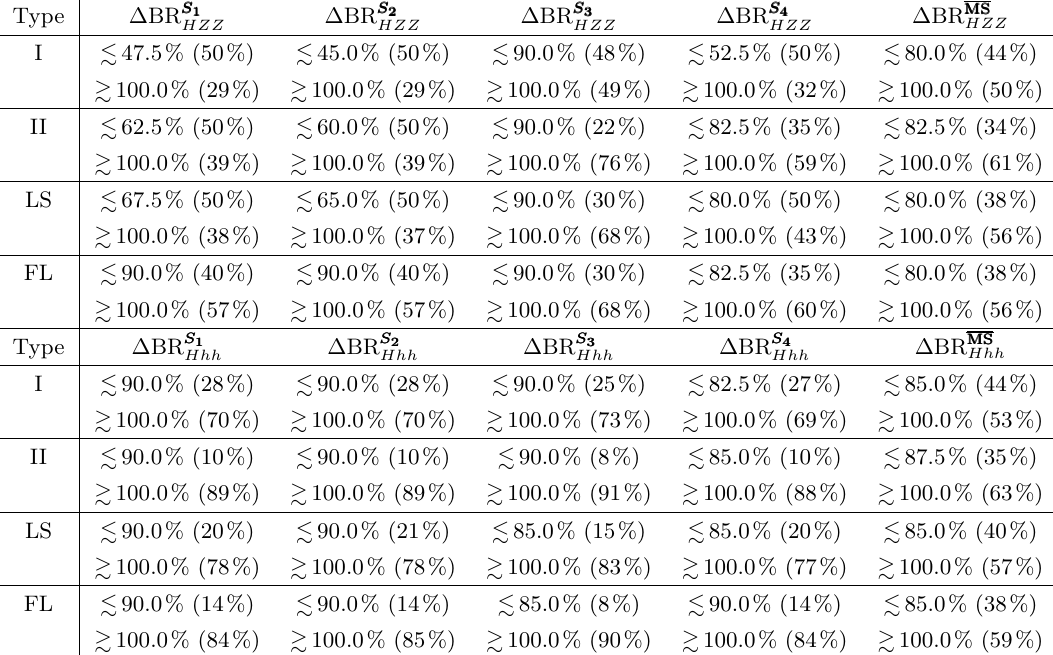
Table 10 . Relative size of the EW corrections to the BRs for the non-SM-like 2HDM Higgs boson H decays into ZZ , and hh , in the four 2HDM types I, II, LS and FL ( h is SM-like). { The decays H ! Z Z and H ! h h typically feature huge EW corrections. For the decay into ZZ , this is mostly due to the smallness of the tree-level width which is proportional to c 2 . As h behaves SM-like, its coupling to massive gauge bosons, (cid:12) (cid:0) (cid:11) proportional to s 2 , is close to one, so that the branching ratio for the decay of (cid:12) (cid:0) (cid:11)